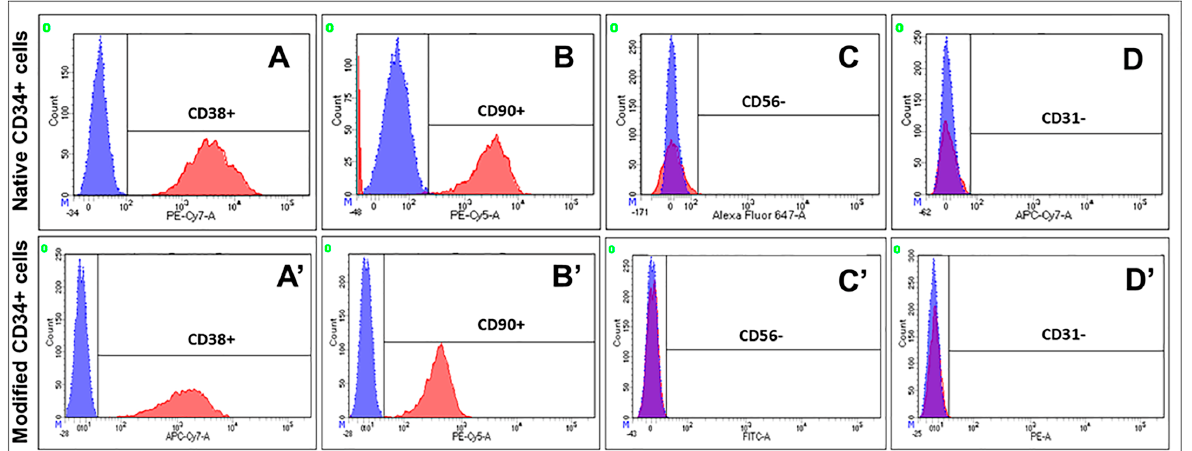
Figure 2. Determination of immune phenotype of CD34 positive cells. ( A , A’ ) staining for CD38+; ( B , B’ ) staining for CD90+; ( C , C’ ) staining for CD56 ( D , D’ ) staining for CD31. Native CD34+ cells—non-treated cells (UCB-MC-NTC). Modified CD34+ cells—cells modified with Ad-VEGF165, Ad-FGF2, and Ad-SDF1 α (UCB-MC-VEGF-FGF2-SDF1 α ). Red peaks—staining with antibodies; blue peaks— negative control (isotype control).